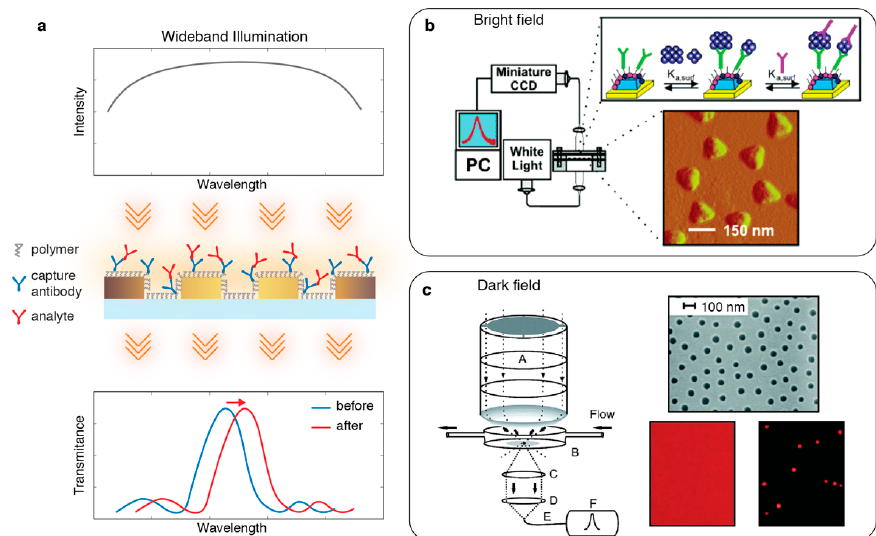
Figure 2. ( a ) Spectral interrogation of nanophotonic sensors. In this representative schematic a collinear light-path is shown, where broadband illumination excites the localized surface plasmons creating a resonance peak in transmission spectrum. The red-shift in the spectral position of the resonance peak can be monitored to extract quantitative analyte binding information; ( b ) Single-point spectroscopy in a bright-field transmission configuration was used to interrogate a nanoplasmonic sensor for the detection of an Alzheimer biomarker. Reprinted with permission from [48]. Copyright 2005 American Chemical Society; ( c ) Single-point spectroscopy in a dark-field transmission configuration was used to interrogate short-range ordered nanoholes. Adapted with permission from [50]. Copyright 2005 American Chemical Society.